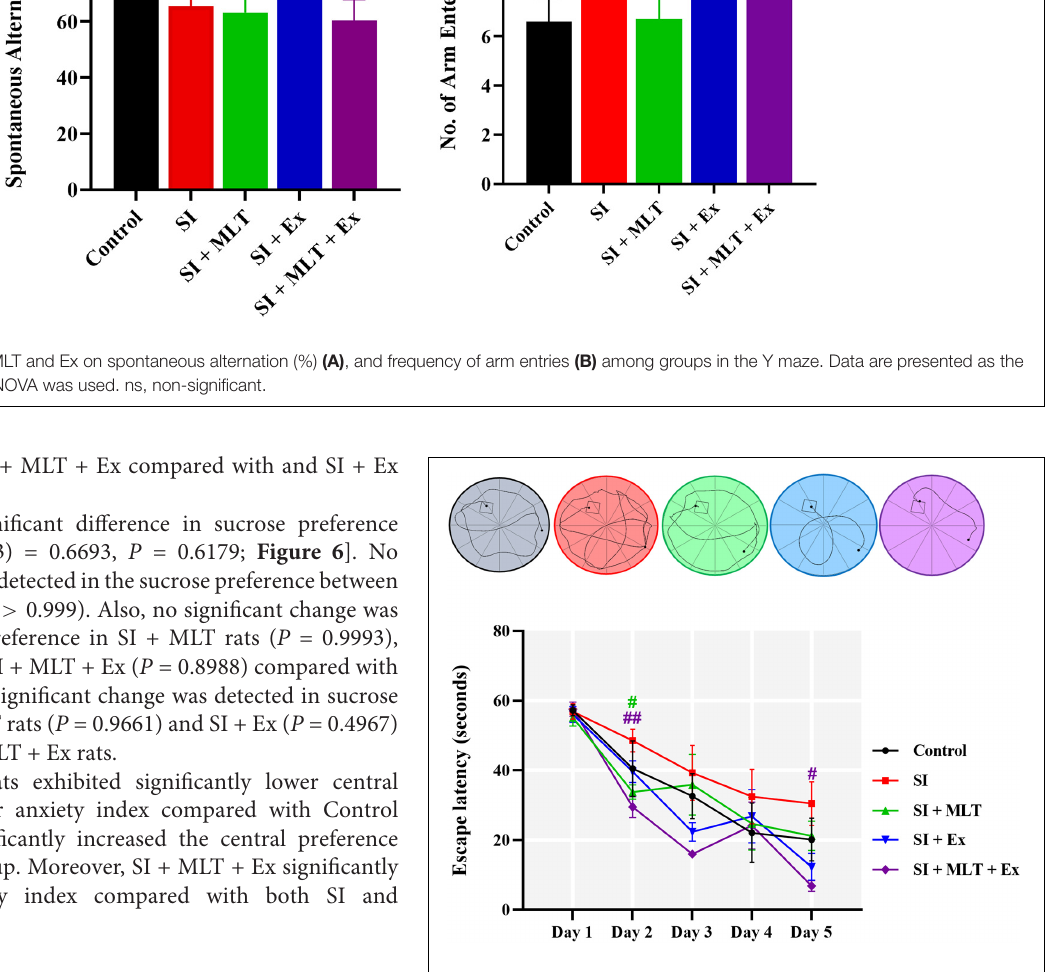
FIGURE 8 | The effect of MLT and Ex on the latency to reach the platform in the MWM among groups of aged rats over 5 days of training. Data are presented as mean ± SEM. Two-way repeated measures ANOVA was used, followed by Tukey’s multiple comparisons test. # indicates a significant difference between treated groups and SI group at p > 0.05; ## p < 0.01. The color of the asterisks denotes comparisons between groups with the matching color and